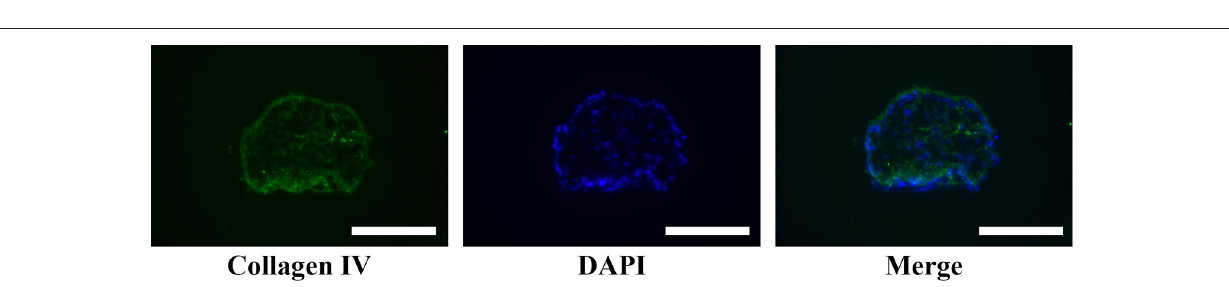
FIGURE 3 | Immunofluorescence showed type IV collagen was positive in the internal part of MTs, reflecting the formation of extracellular matrix in MTs. Inserted bar = 200 µ